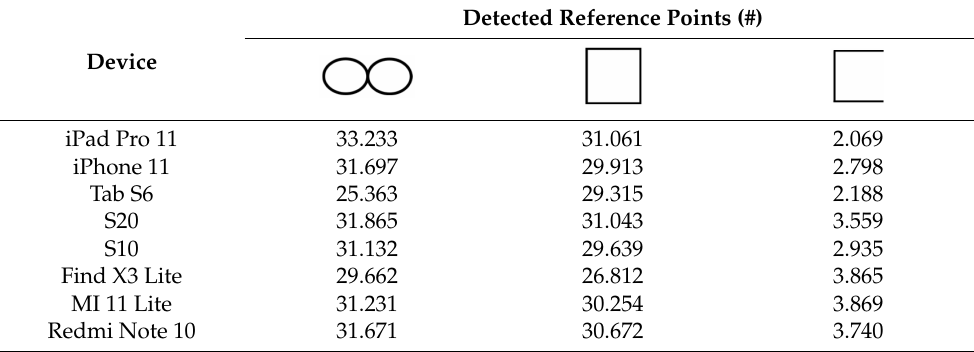
Table 5. Averaged number of feature points detected by the selected devices in relation to the three